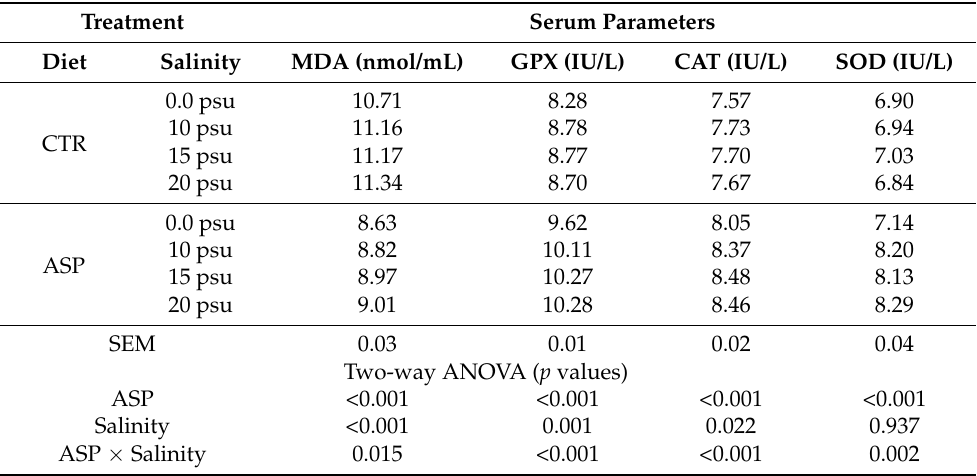
Table 3. Serum antioxidant biomarkers of Nile tilapia fed a basal diet (CTR) compared to those fed on diets supplemented with Aspergillus oryzae (ASP) for 12 weeks and then exposed to different salinity levels for 15